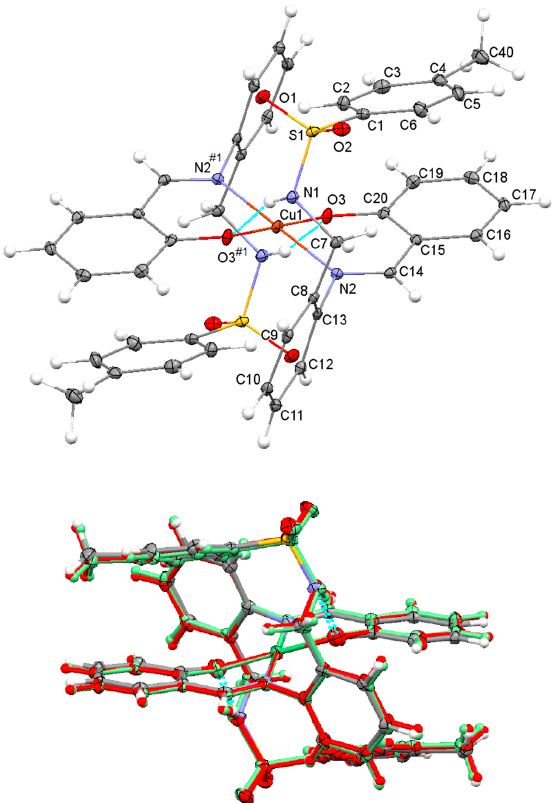
Figure 2. Top : Ellipsoid view of the molecular structure of Cu(HSB) 2 with intramolecular N–H ··· O interactions (only labels for the asymmetric unit, jointly with the donor atoms N2 and O3 generated by symmetry have been included). Bottom : Overlay of the molecular structures of Ni(HSB) 2 (in standard colors), Pd(HSB) 2 (in red color) and Cu(HSB) 2 (in green color).